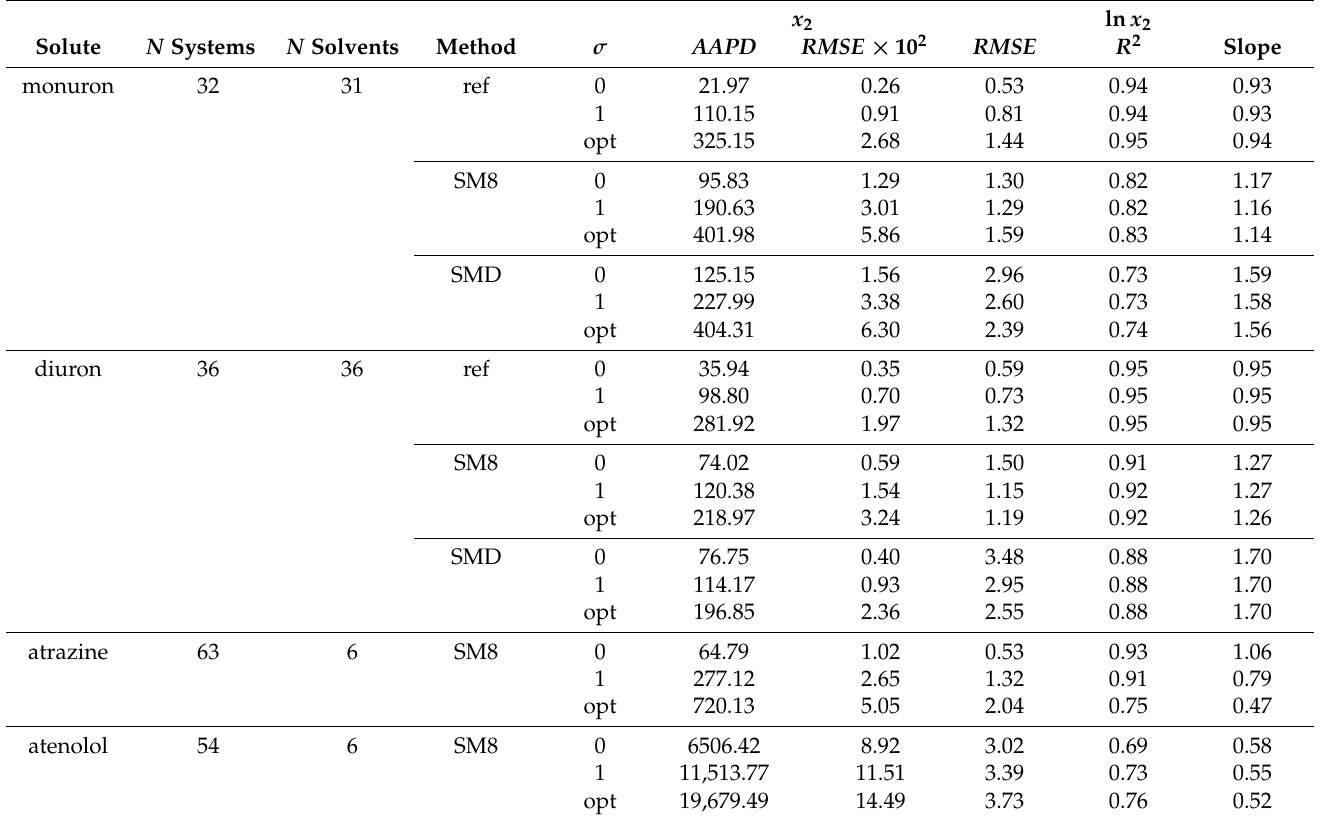
Table 3. A summary of the predicted solubility ( x 2 ) in non-aqueous solvents. For all cases we consider partial atomic charges obtained using the SM8 solvation model. For monuron and diuron we additionally considered partial atomic charges obtained using the SMD solvation model, and we list the results using MOSCED parameters regressed in ref. [12] using experimental solubility data (ref). N systems and N solvents corresponds to the number of systems and solvents, respectively, and AAPD and RMSE are resulting average absolute percent deviation and root mean squared error, respectively. R 2 and slope are the resulting coefficient of determination and slope of the corresponding parity plot. Please note that N systems ≥ N solvents because of the possibility of multiple